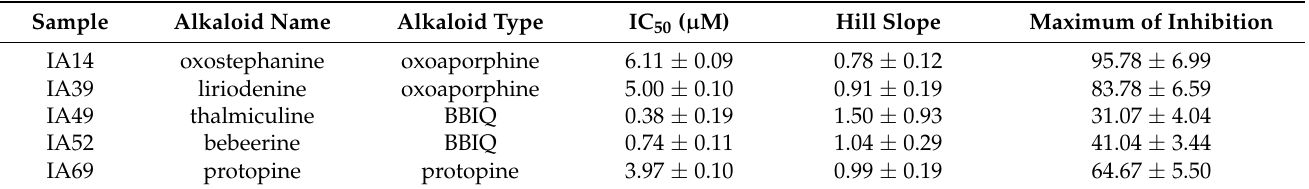
Table 2. Curve fitting parameters of the concentration–inhibition relationships of oxostephanine, liriodenine, thalmiculine, bebeerine, and protopine.